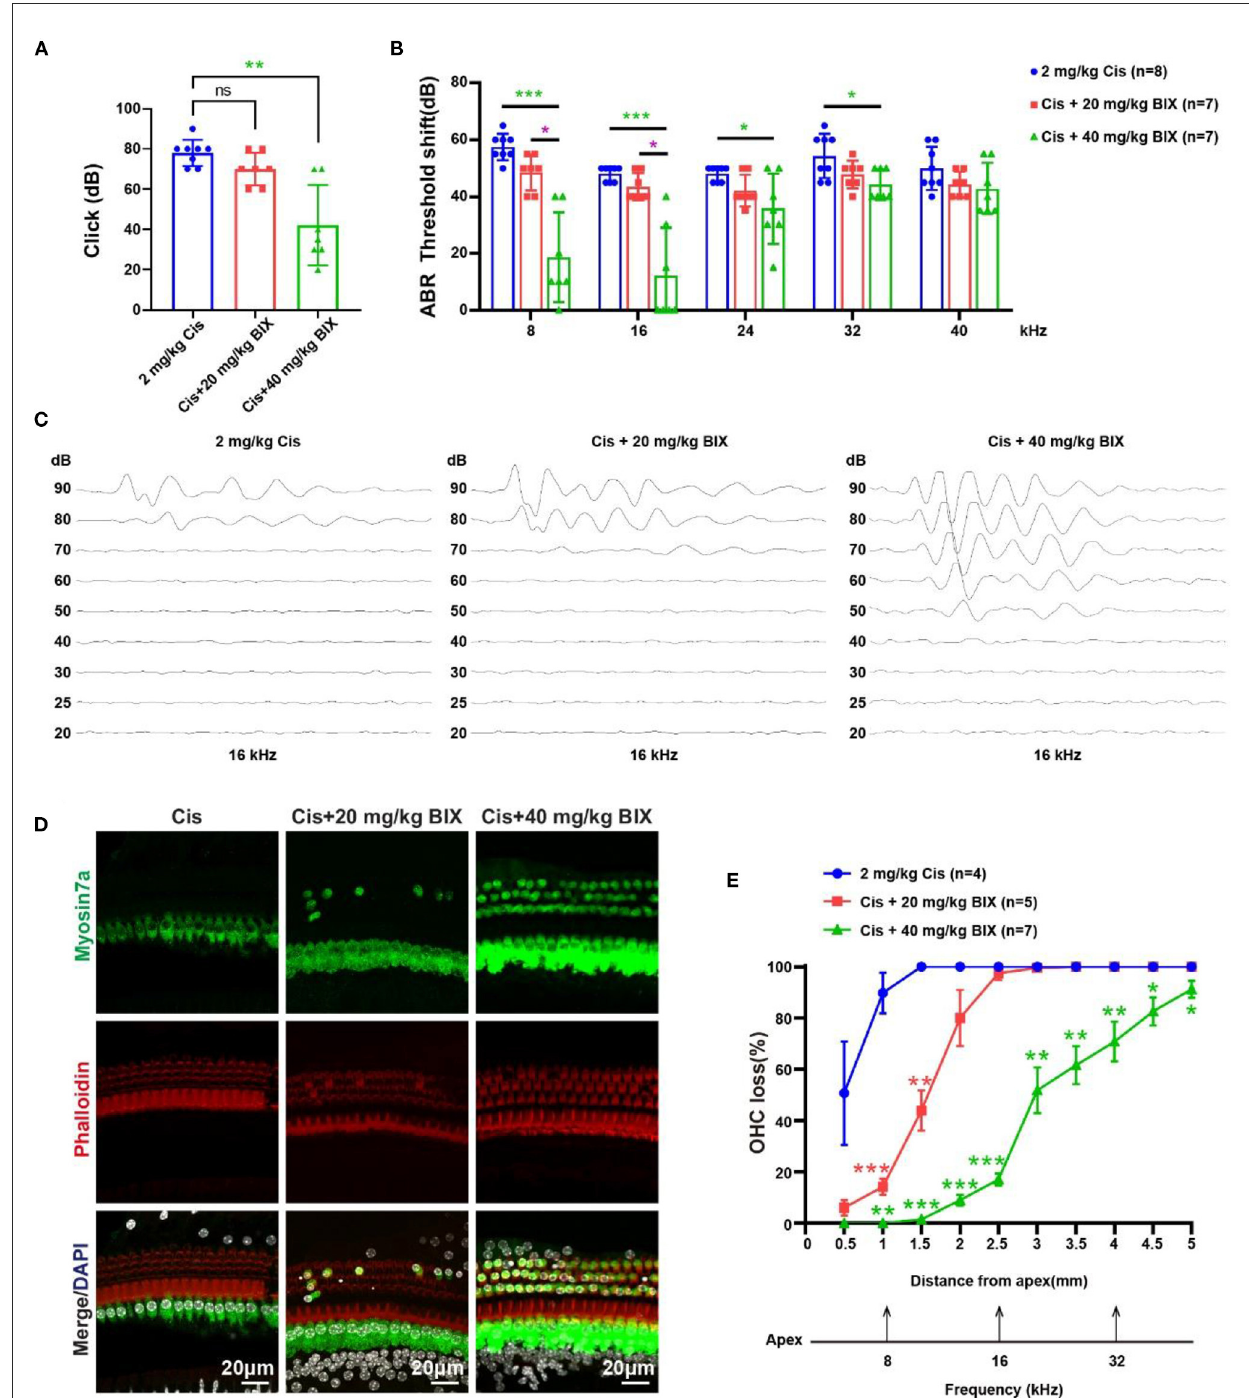
FIGURE9 Results of the mouse hearing loss treated with cisplatin and BIX01294. (A) Statistical scatter plot of the click ABR. (B) Statistical line chart of the tone burst ABR threshold shifts. (C) Tone burst ABR at 16kHz. (D) Immunofluorescence staining with myosin7a, phalloidin and DAPI of middle turn in the cochlea. (E) Quantification of the immunofluorescence staining in the cochlea. * p < 0.05, ** p < 0.01, *** p < 0.001.